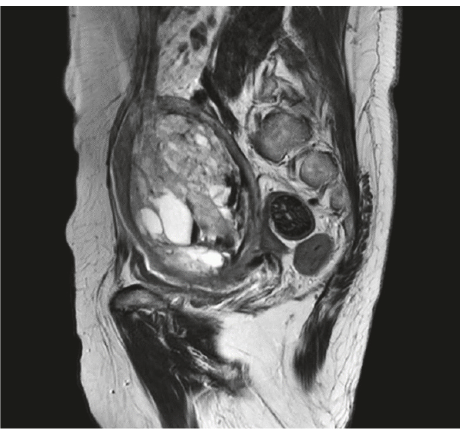
Figure 1: Large uterine tumor with deep myometrial invasion (MRI pelvis, T2 weighted sagittal).